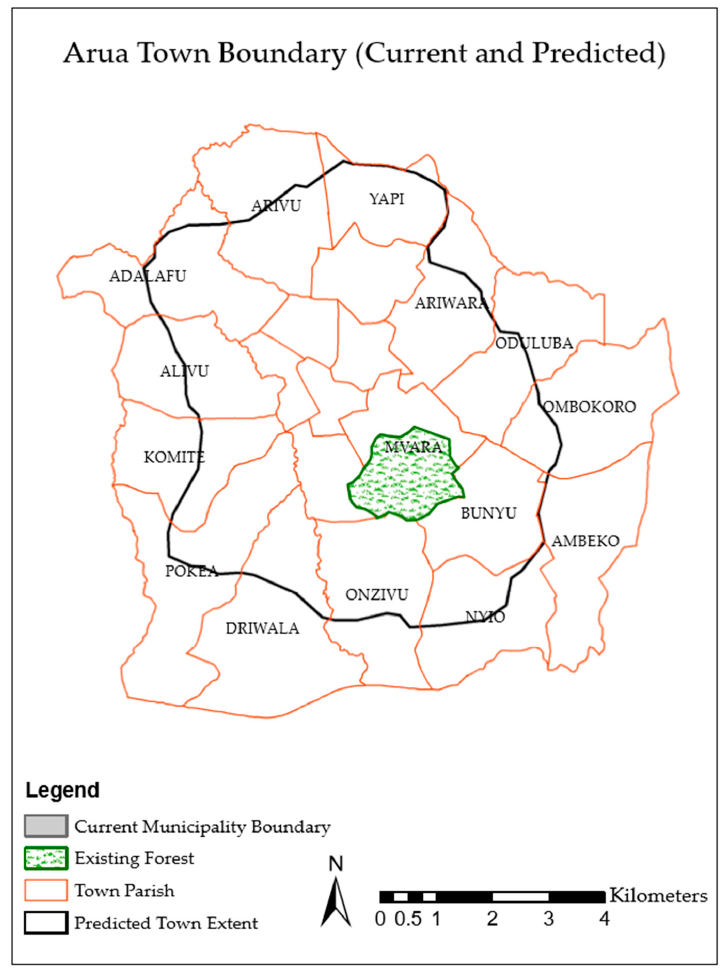
Figure 6. Predicted spatial extent of Arua in year 2032.